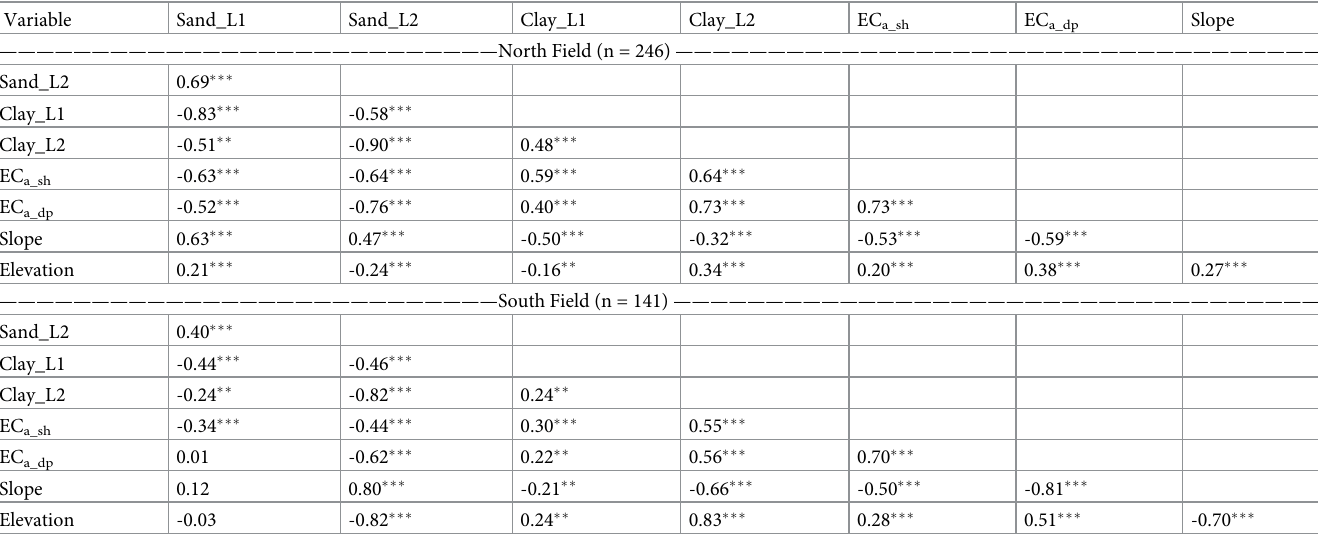
Table 1. Correlations between sand content, clay content, EC a , elevation and slope for two fields within a 194-ha farm in Hale County, Texas, in 2017.